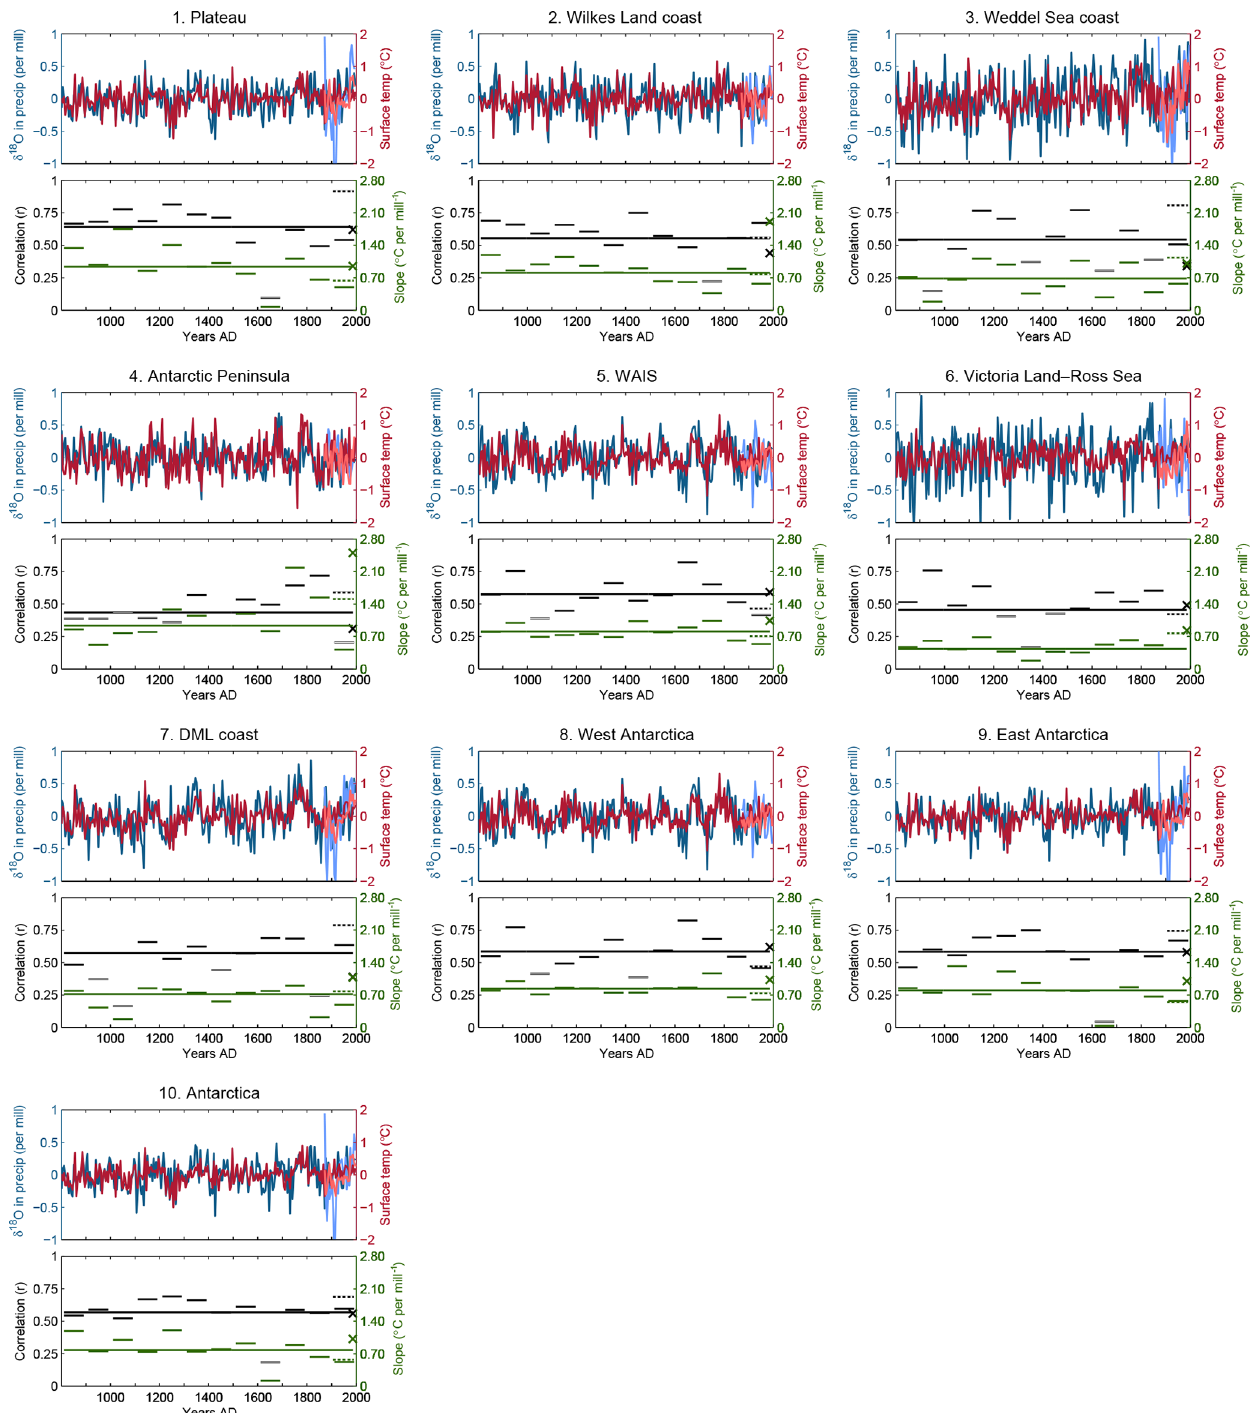
Figure 4. Upper panels: evolution of 5-year averaged δ 18 O in precipitation (blue) and surface temperature (red) over the 800–1999CE period in ECHAM5/MPI-OM and over the 1871–2011CE period in ECHAM5-wiso (lighter colors). Lower panels: Pearson correlation coefficients (black) and slope (in ◦ C‰ − 1 , in green) between the two variables in ECHAM5/MPI-OM (horizontal solid bars) and in ECHAM5-wiso (horizontal dashed bars). The lengths of the bars correspond to the period over which the diagnostics are computed. The black bars filled with white represent that the correlation is not statistically significant at the 0.05 level. The diagnostics were only computed over the 1900– 2000CE period for ECHAM5-wiso. The crosses represent the correlation coefficients and the slopes (in ◦ C‰ − 1 ) between the same variables based on another ECHAM5-wiso simulation, over the 1979–2013CE period, using annual mean values (Stenni et al., 2017).